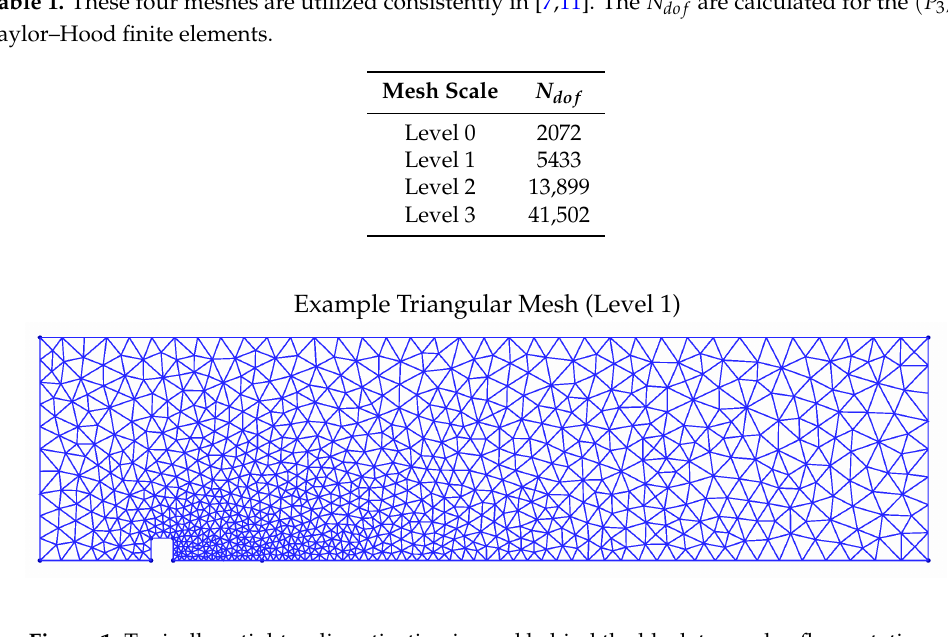
Figure 1. Typically, a tighter discretization is used behind the block to resolve flow rotations.